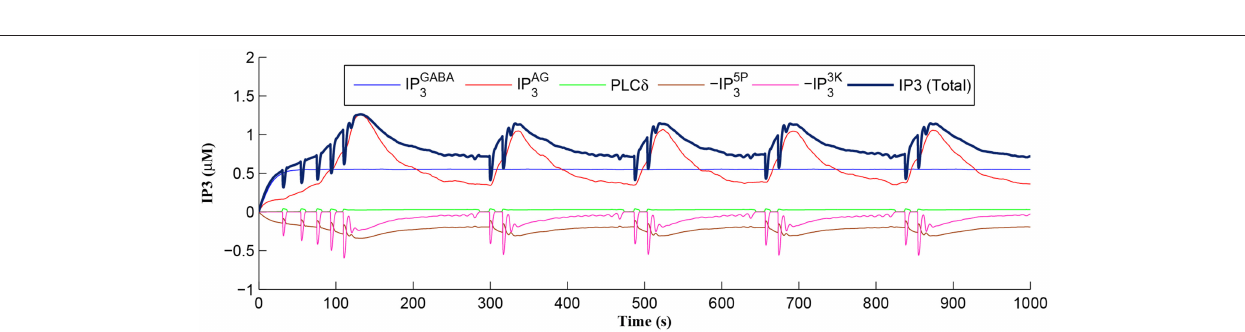
FIGURE 7 | IP 3 dynamics within the astrocyte cell over time. The overall IP 3 includes contributions from IP GABA 3 , IP AG 3 , PLC δ , IP 5 P 3 , and IP 3 K 3 , where the degradations of IP 3 , IP 5 P 3 , and IP 3 K 3 , are shown as negative